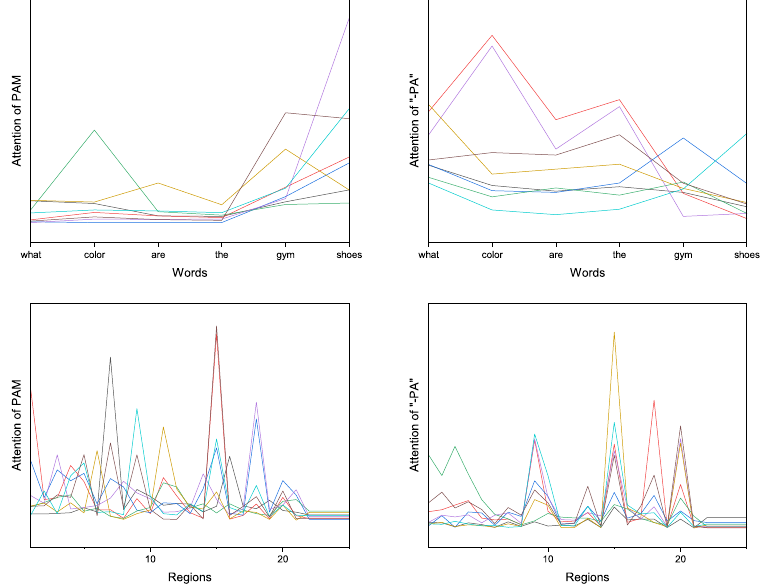
Figure 6. An example of attention distribution by 8 heads, the left two from PAM and the right two from “-PA”. The path-wise attention block helps the model focus on useful information to answer the